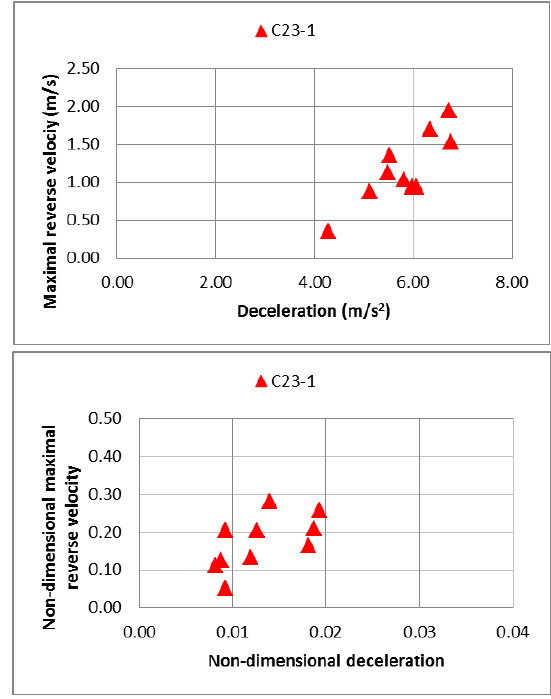
Fig. 15. Dynamic properties – reverse velocity dependence on system deceleration